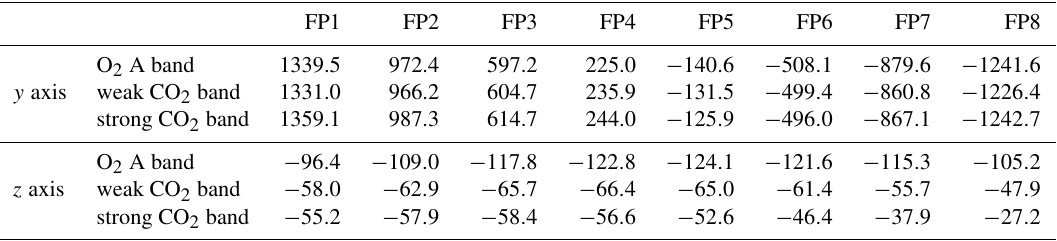
Table 1. OCO-2 v9 instrument-to-spacecraft pointing offsets for each spectral band along the y axis and z axis relative to the central boresight of the telescope in units of arcsec.